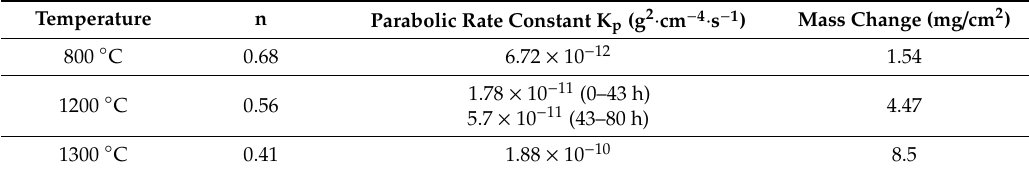
Table 1. Mass change, n values and oxidation rate constants of the alloy OHC3 for isothermal oxidation at 800, 1200, and 1300 °C.